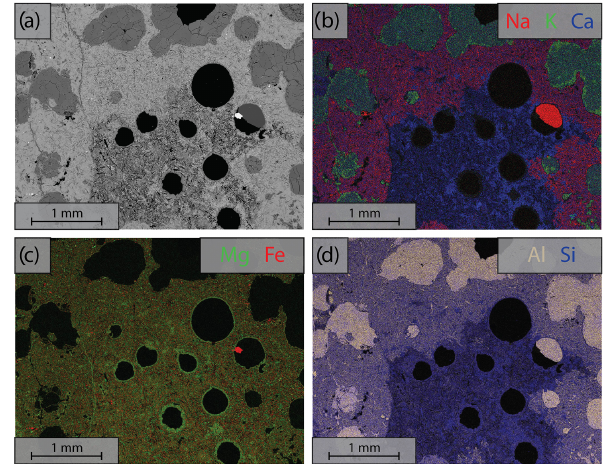
Figure A1. Energy dispersive spectroscopy (EDS) analysis of the area marked in Fig. 1; color composite images are made by com- bining RGB channel where the individual channels contain element concentration. (a) Backscattered electron (BSE) images of the start- ing material; (b) elemental composition of Na, K and Ca; (c) ele- mental composition of Mg and Fe; (d) elemental composition of Al and